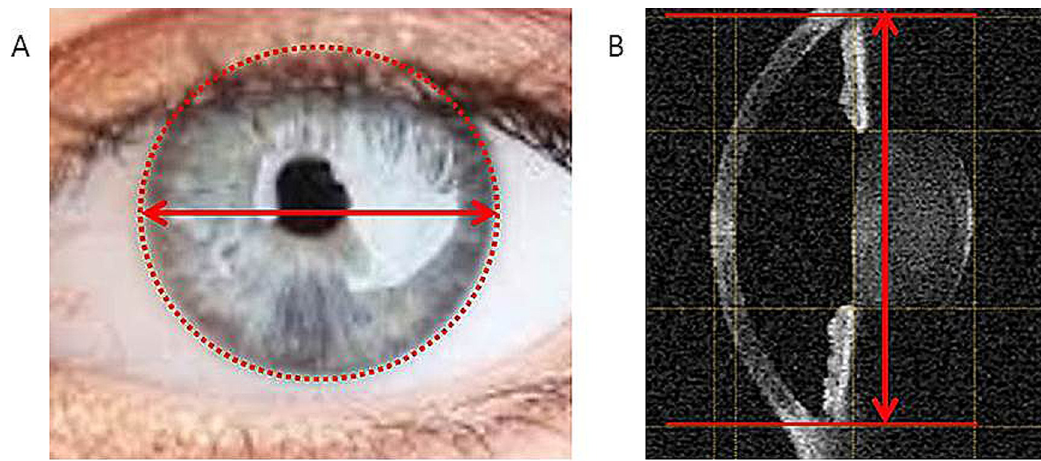
Fig 6. WTW measurements of each device. The two IOLMaster devices produce a camera image using LED light source and measure the diameter of a circle fitted to the corneal contour from the camera image (A). Argos tries to identify the junction of the posterior cornea and iris